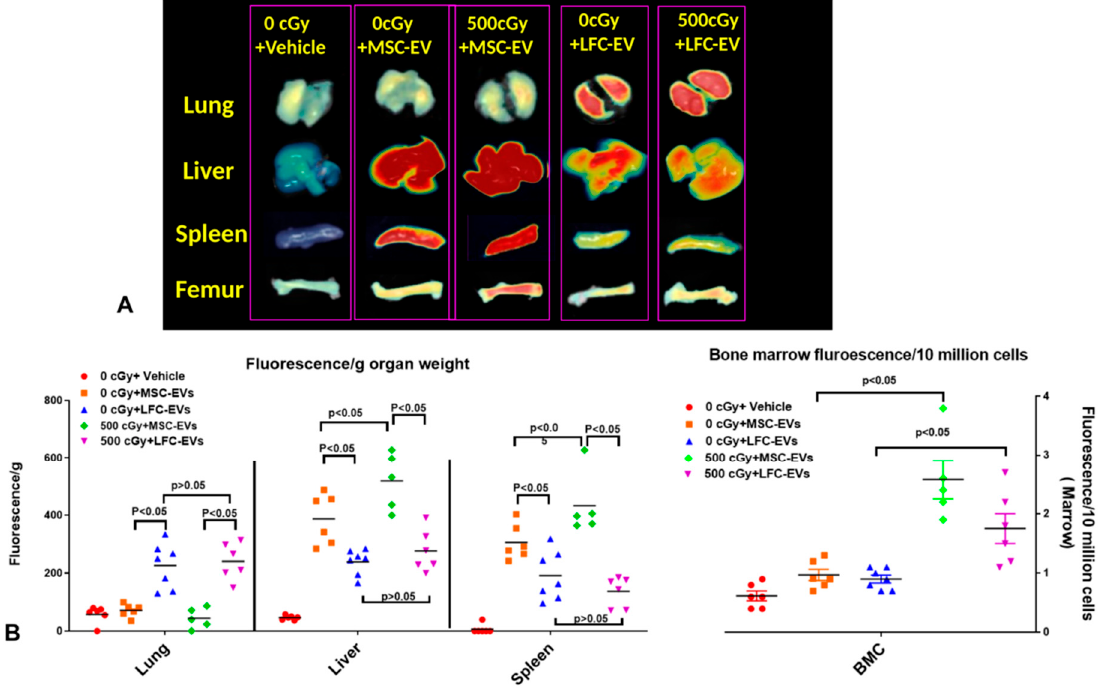
Figure 3. MSC-EV and lung fibroblast cells derived EV (LFC-EV biodistribution in mice. ( A ) Representative tissue organ FMT images from mice infused with DiD-labeled MSC-EVs and FLC-EVs. ( B ) Quantification analysis of fluorescence intensity in tissues ( n = 5 or 6 mice / group). The results were analyzed by one-way ANOVA with a multiple comparisons test.